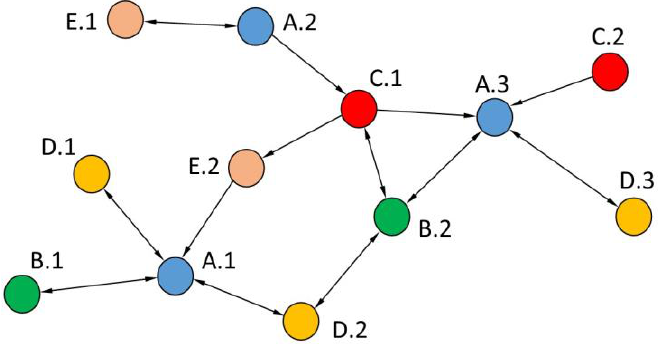
Figure 3: Figure 2. An example of an influence propagation digraph at a specific